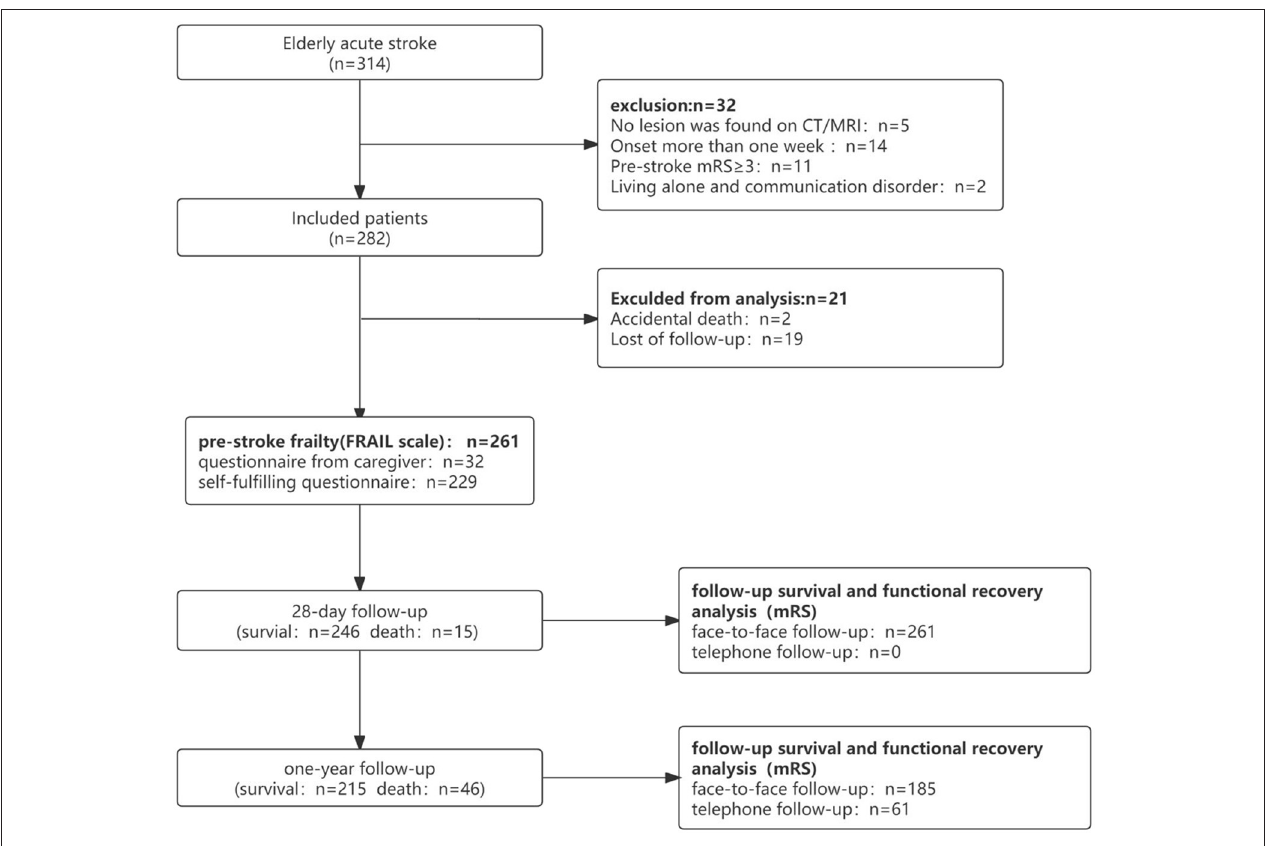
FIGURE 1 | Diagram of the study design.